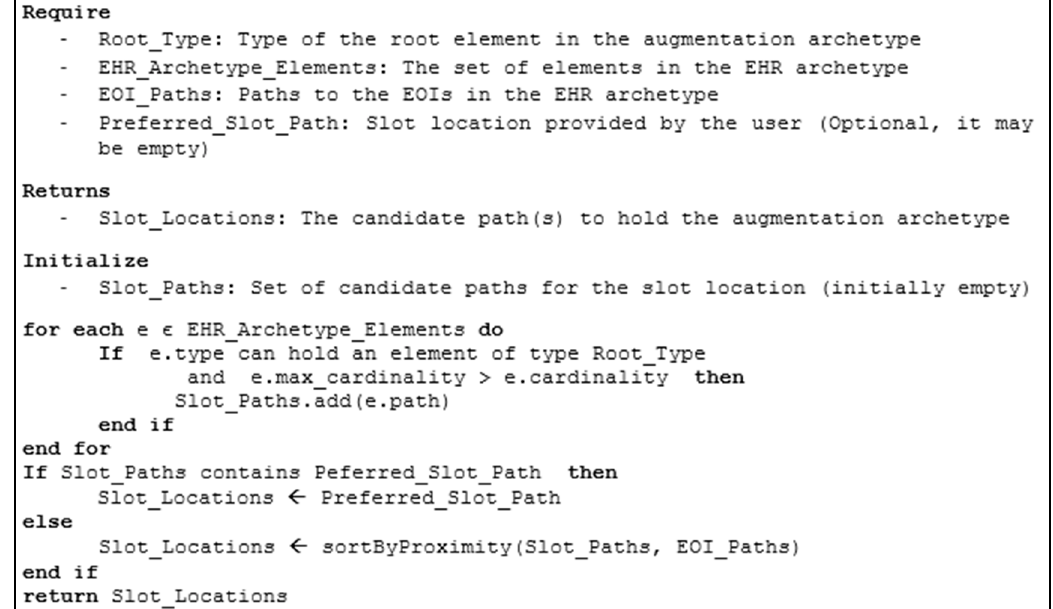
Figure 7. Proposed algorithm to determine components in the initial EHR archetype candidate to include the slot reference for the augmentation content.